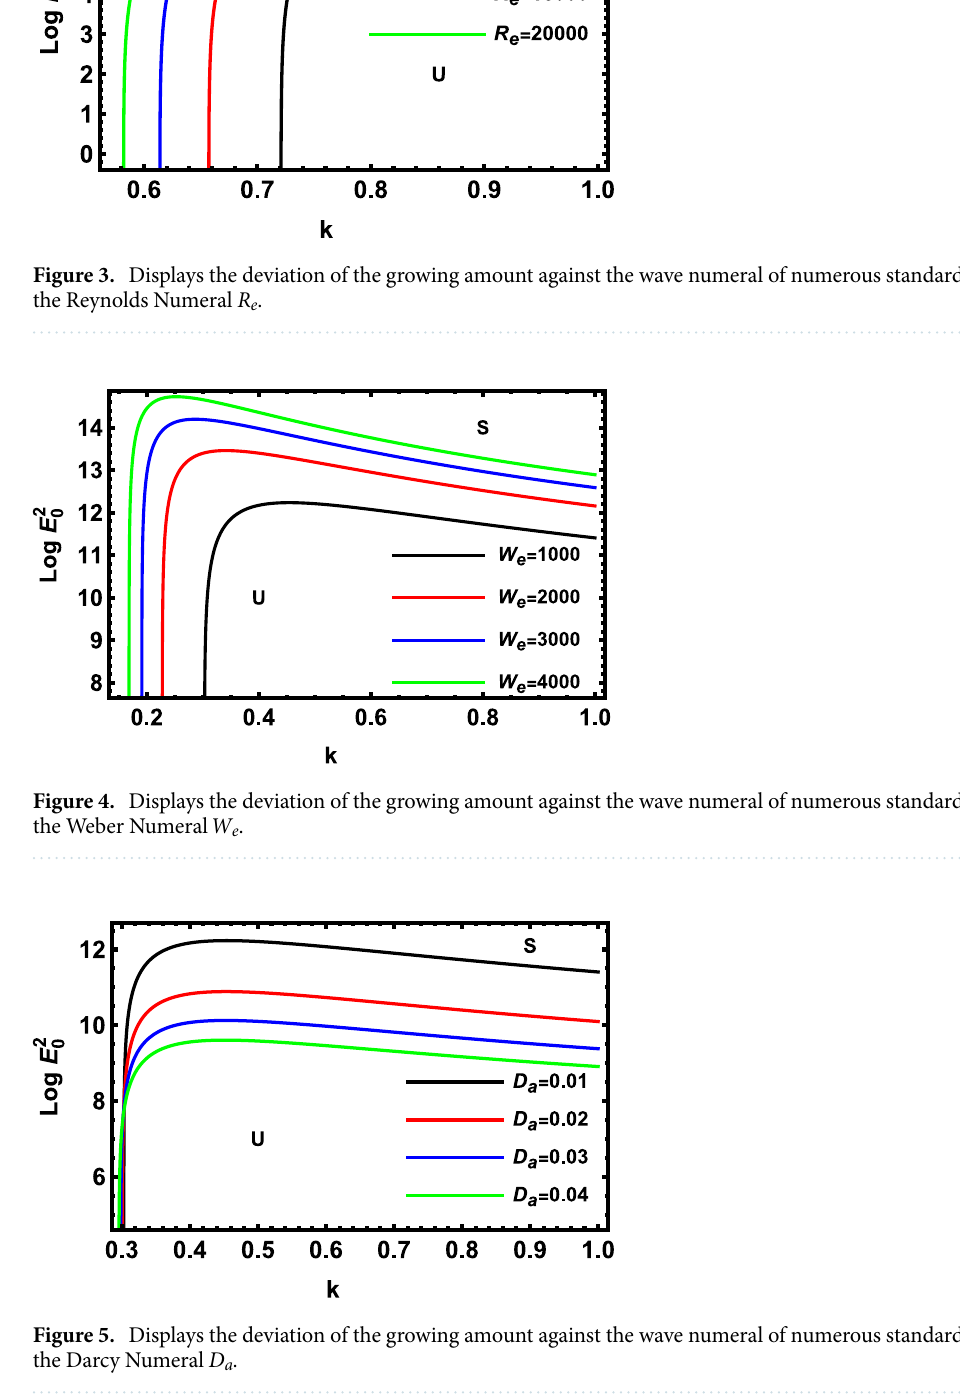
ent that the stable zone increases as the values of R e are reduced. Therefore, the Reynolds numeral provides a destabilizing impact on the considered model. Physically, the rise in the streaming fluid cylinder destabilizes